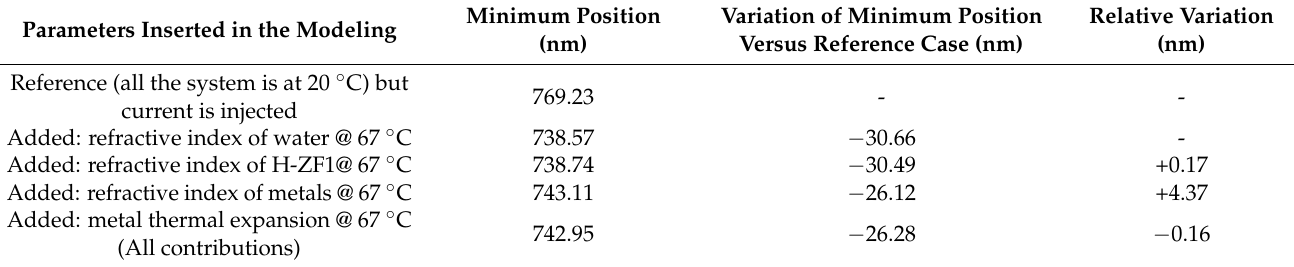
Table 2. Position of the response curve minimum following the gradual insertion of temperature-dependent parameters (rise of 47 ◦ C) in the modeling.